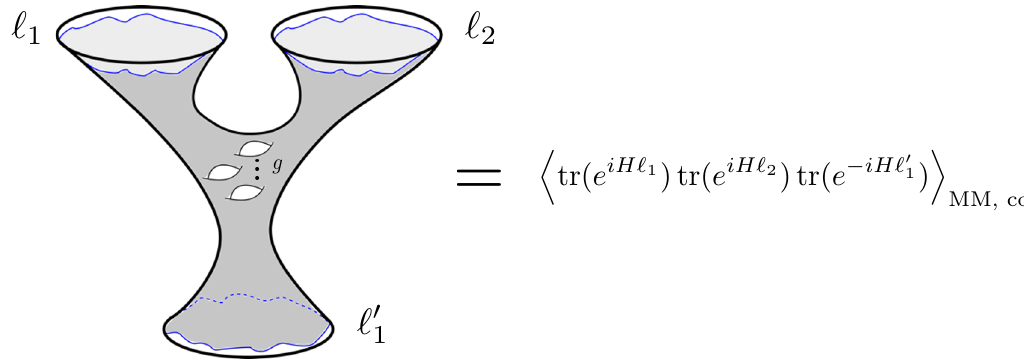
Figure 4 . An entry in the dictionary between the matrix integral and de Sitter JT gravity. The JT partition function on a genus g surface with two future boundaries and one past boundary is equal to the indicated three-point function of the matrix ensemble. See